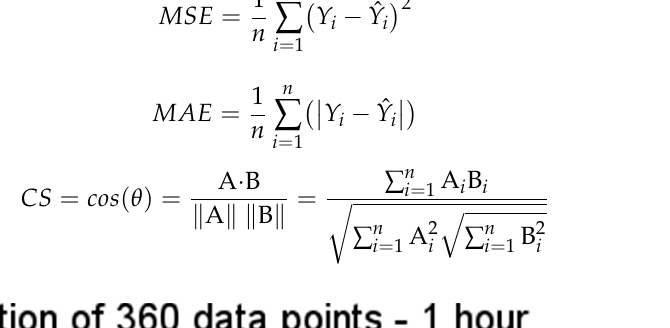
Figure 7. Comparison of the learning process of different types of LSTM and CNN networks in the 2 h forecasting horizon: X -axis—next epochs, Y -axis—error level.